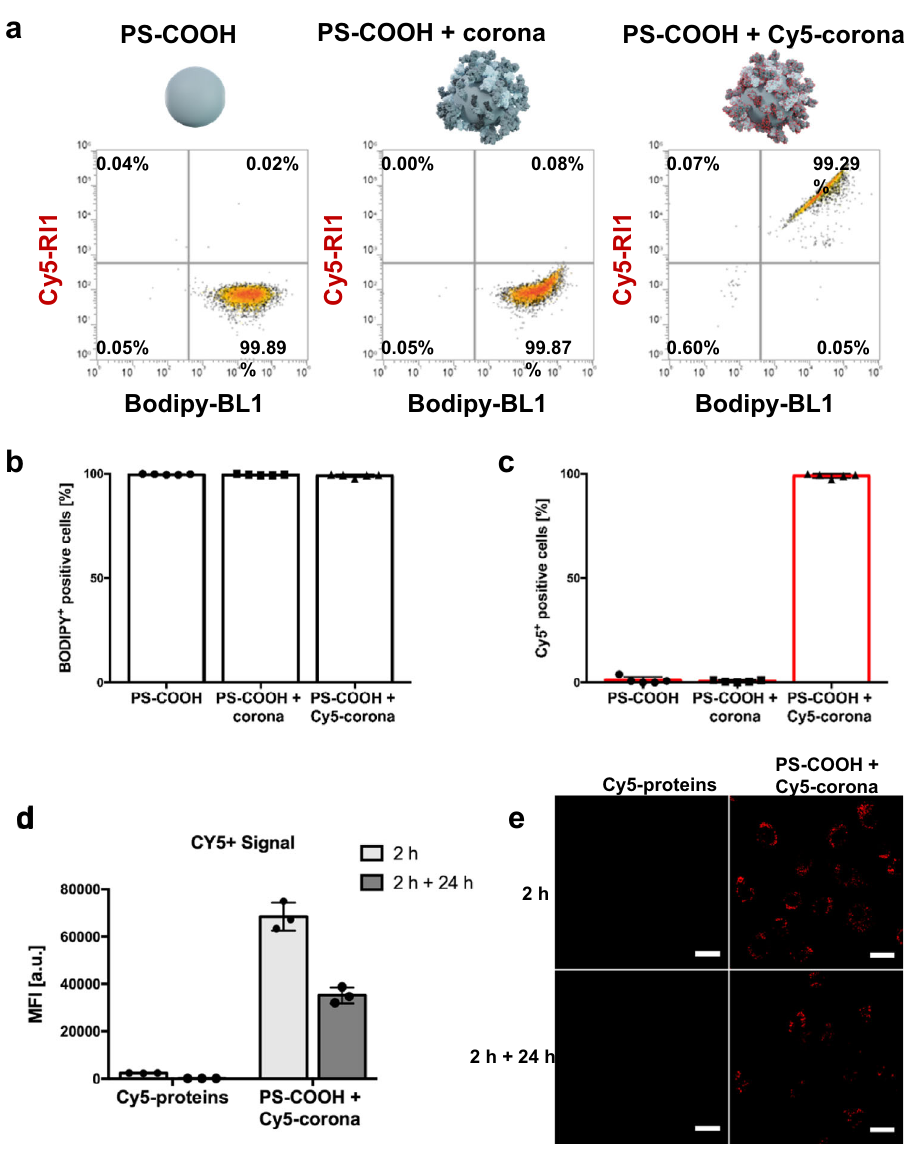
Fig. 2 | Cy5-labeled protein corona is detectable after uptake in murine mac- rophages. a RAW264.7 cells were incubated with 150 µ gmL − 1 of carboxyl- functionalizedPSNPsfor2h.UntreatedNPs,NPswithanunlabeledproteincorona, and NPs with a Cy5-labeled protein corona were used for the uptake experiment. Flow cytometrywas performedto measureBODIPY(PS NPs) fl uorescenceand Cy5 (labeled corona proteins) fl uorescence. Values are shown as the percentage of measuredeventsregardingthe fl uorescence. b ThepercentageofBODIPY-positive cells is shown c The percentage of Cy5-positive cells is shown (data is shown as mean±SD, n =5). d As a control experiment, RAW264.7 cells were incubated with 9 µ gmL − 1 Cy5-labeled murine plasma proteins and 150 µ gmL − 1 of PS NPs with a